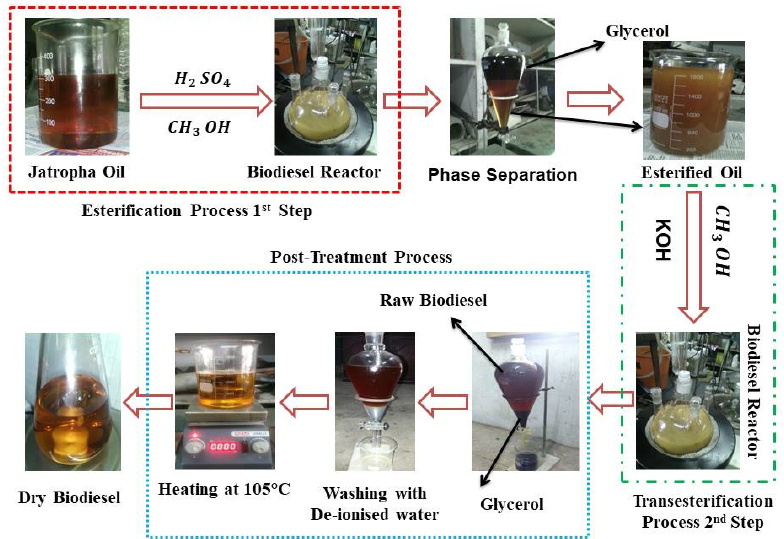
Figure 1. Two-stage biodiesel production process (jatropha biodiesel).